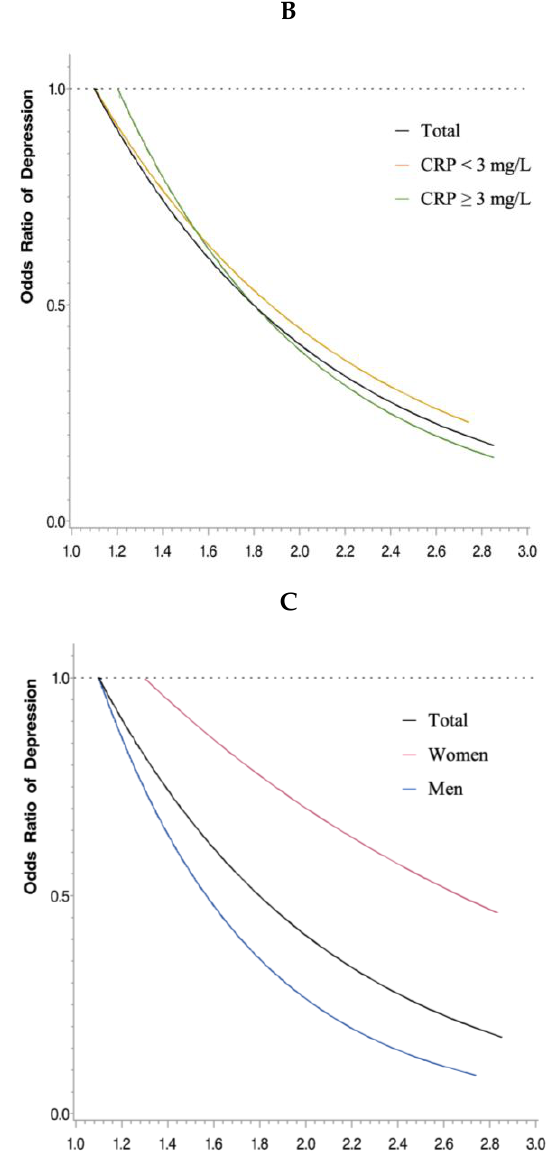
Figure 3. The restricted cubic spline model of the odds ratios of depression with serum magnesium levels (mg/dL). ( A ) The black line represents the total sample, the orange line represents CRP levels <5 mg/L, and the green line represents CRP levels ≥5 mg/L. ( B ) The black line represents the total sample, the orange line represents CRP levels <3 mg/L, and the green line represents CRP levels ≥3 mg/L. ( C ) The black line represents the total sample, the pink line represents women, and the blue line represents men. All models were adjusted for age, income, smoking status, physical activity status, kidney disease, and CRP levels.